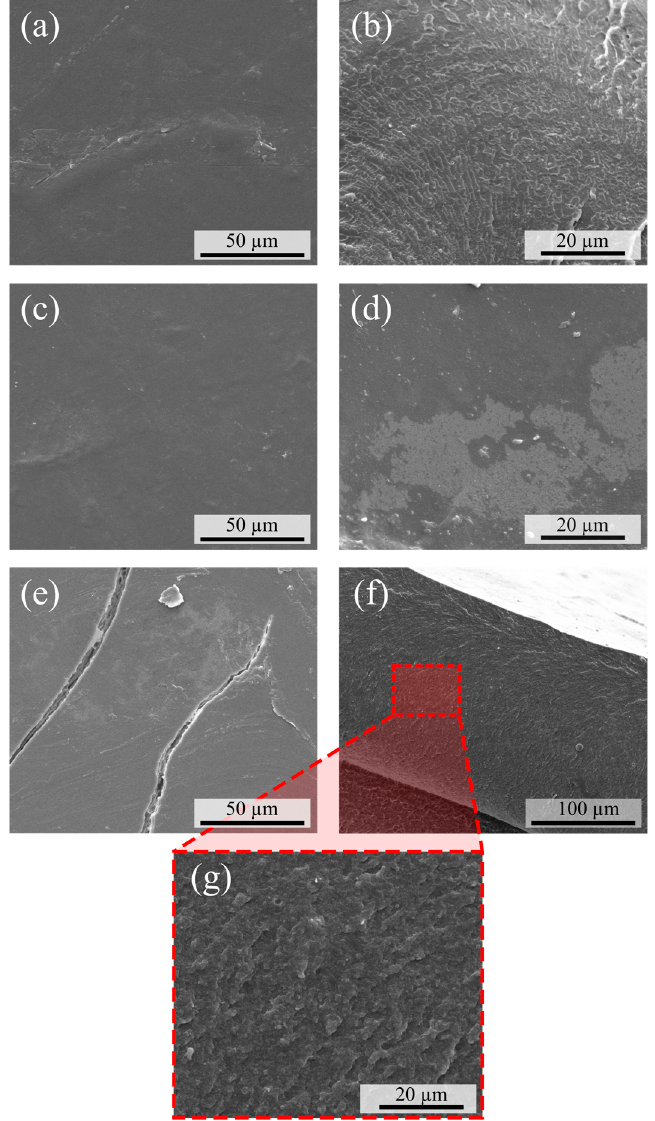
Figure 9. SEM images of the surfaces (left column) and cross-sections (right column) of ( a , b ) neat PC film, ( c , d ) PC only submitted to scCO 2 at 60 °C and 10 MPa, and ( e – g ) PC impregnated with clove extract at 60 °C and 10 MPa with CL% = 18.5%.